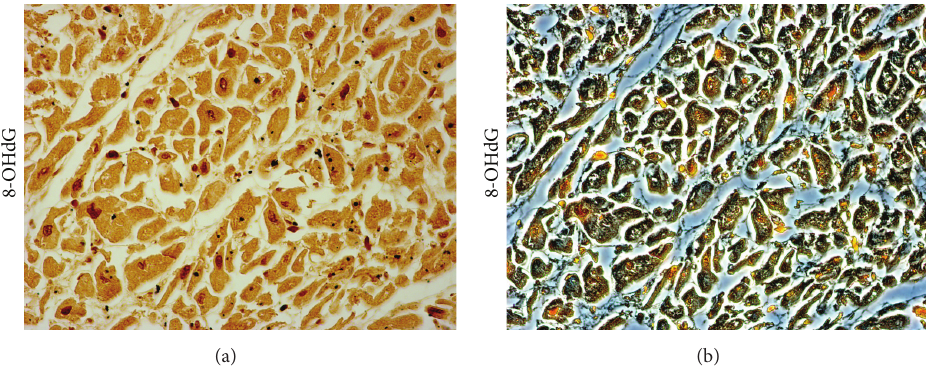
Figure 4: 8-Hydroxy-2 󸀠 -deoxyguanosine (8-OHdG) expression in the cardiac tissue of patient died following sepsis. Bright field (a) and contrast phase (b) microscopy image of cardiac sample of a septic patient, showing a high positive rate of 8-OHdG expression in myocardial nuclei using an anti-8-hydroxy-2 󸀠 -deoxyguanosine (8-OHdG) antibody (JaICA, Japan). Personal observation of a 31-year-old woman with severe burn wounds of the right thigh. After two days of antibiotic therapy, her clinical condition worsened with the onset of cardiac failure symptoms. Immediate transthoracic echocardiogram revealed profound diffuse hypokinesis and severely depressed systolic function of the left ventricle with ejection fraction of 21%, right ventricular dilatation, and no valvular abnormalities. Fluid and vasopressor support were started; however, several hours later, LV function started to deteriorate with severe hemodynamic instability and progression to